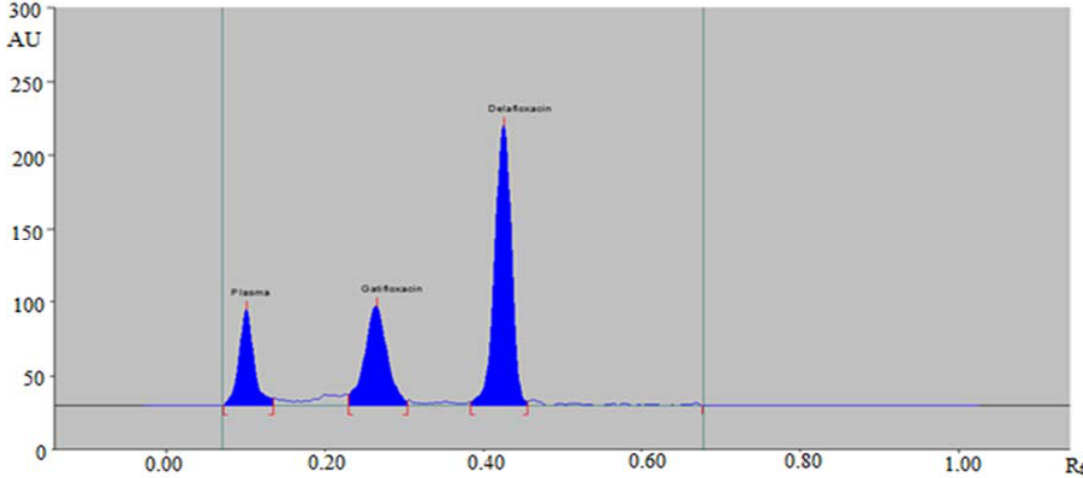
Figure 3. HPTLC densitogram of plasma sample spiked with DLX (100 ng / band) and (IS) (150 ng / band).